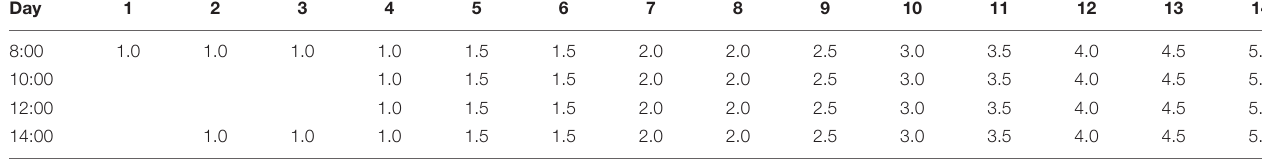
TABLE 1 | Dosing schedule of Methamphetamine (METH) treatment (mg/kg). Day